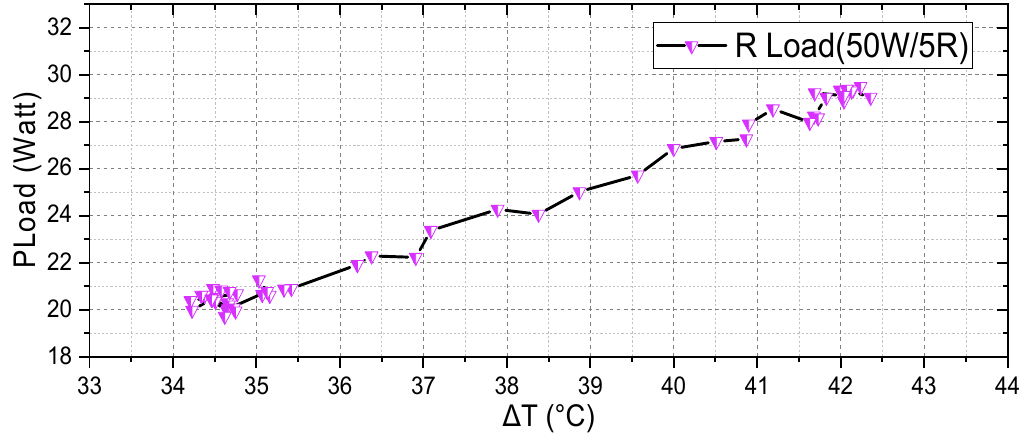
Figure 11. Power for 15 × 10 TEG panel at load of (50 W / 5 Ω ).